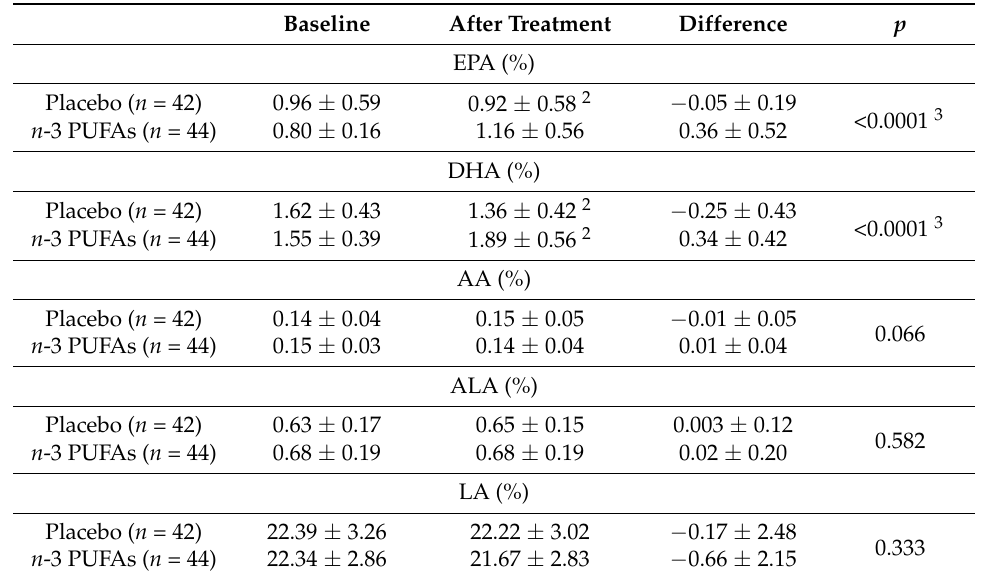
Table 2. Changes in plasma PUFA levels of MCI patients 1